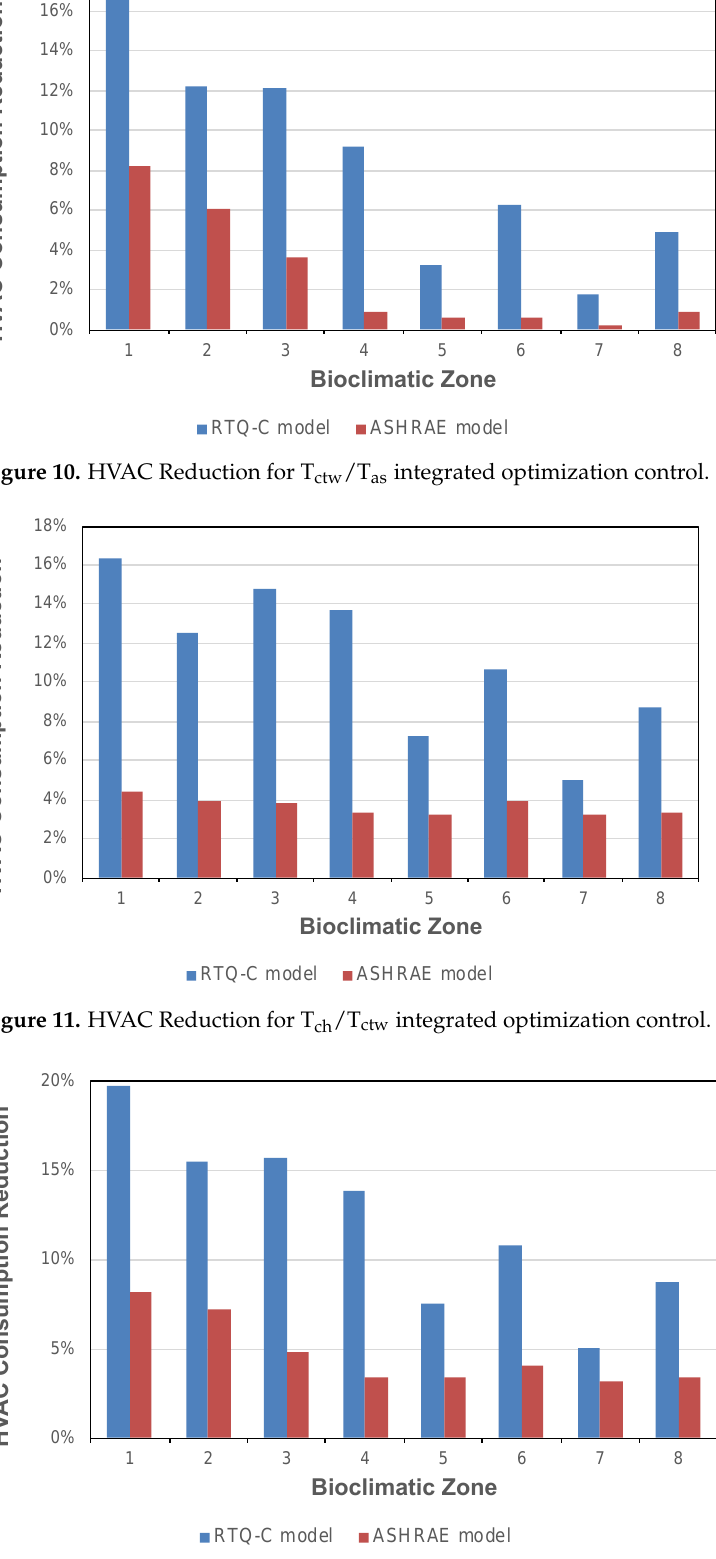
Figure 12. HVAC Reduction for T ch /T ctw integrated optimization control.